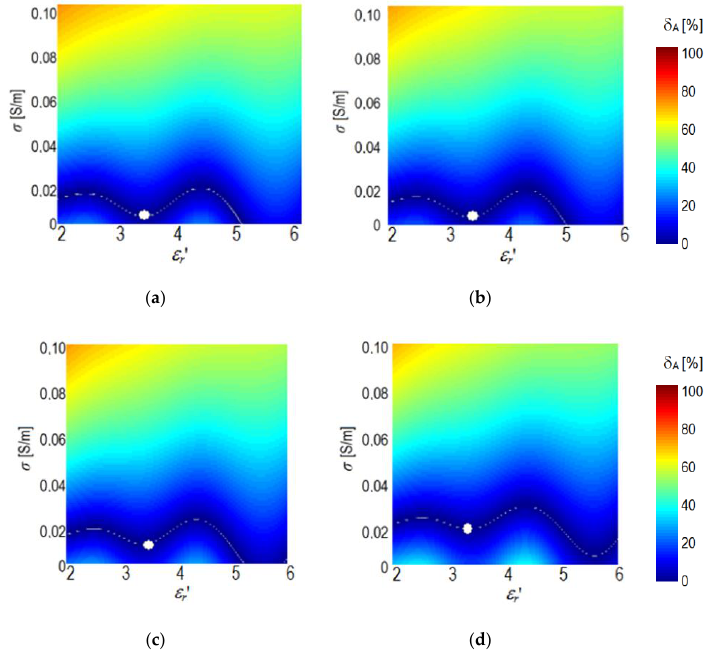
Figure 11. Relative error between numerical and analytical values of transmission coefficient (single-layer wall made of bricks B30) for: ( a ) σ FDTD = 0.01 S / m, ( b ) σ FDTD = 0.02 S / m, ( c ) σ FDTD = 0.03 S / m, ( d ) σ FDTD = 0.04 S /